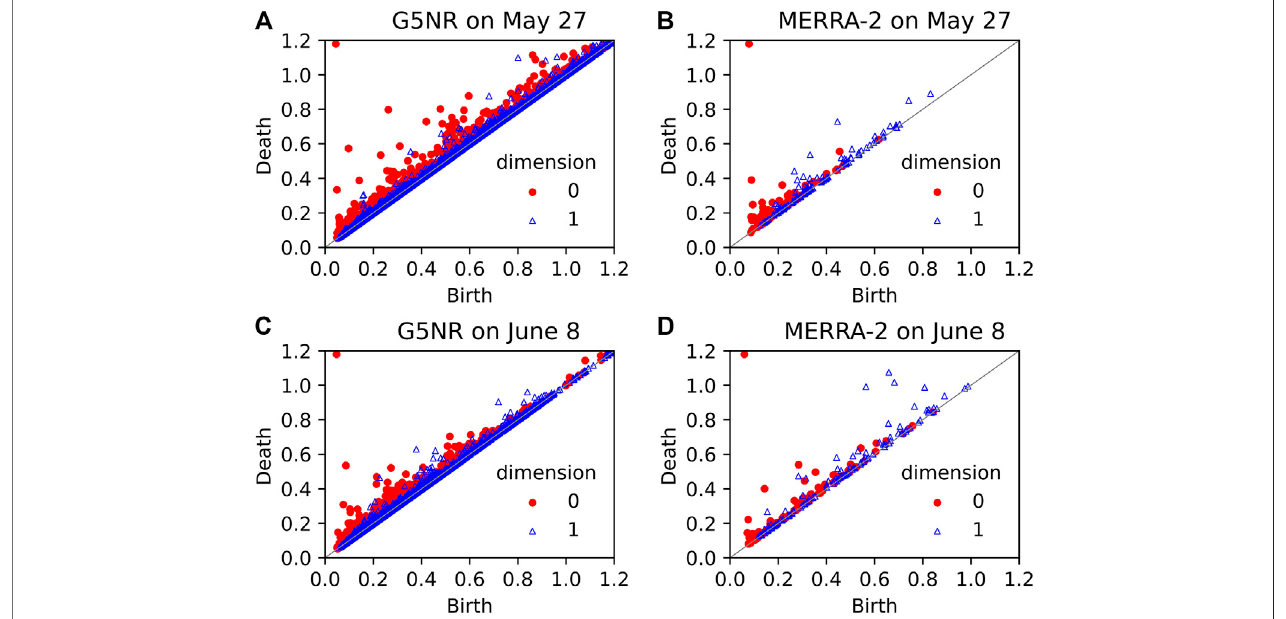
FIGURE 4 | (Top) Persistence diagrams for (A) G5NR and (B) MERRA-2 on May 27th, 2006. (Bottom) Same as (A) – (B) but for June 8th,